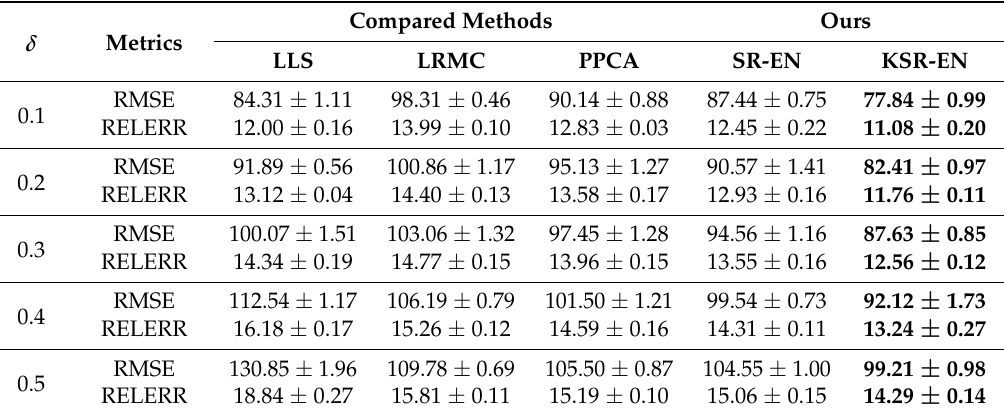
Table 3. Imputation error RMSE and RELERR obtained by different approaches under missing at random (MAR) missing pattern. The best results are highlighted in bold.